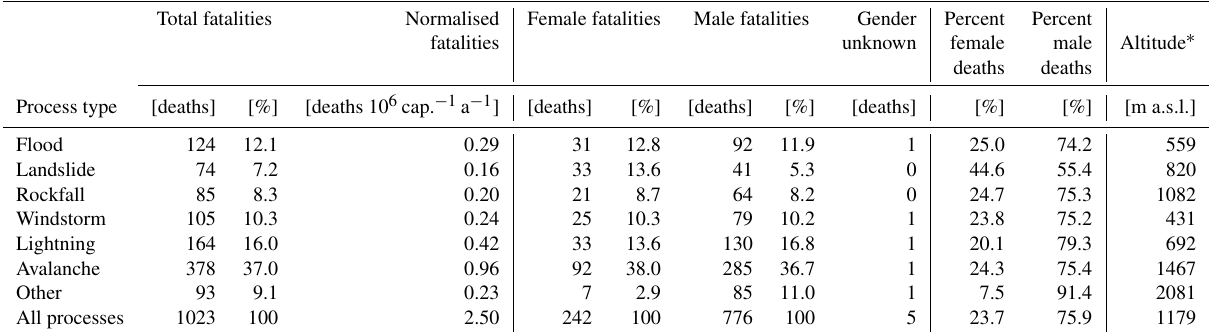
Table 1. Natural hazard fatalities in Switzerland (1946–2015) classified by gender. The last column indicates the median altitude at which victims of natural hazards died.